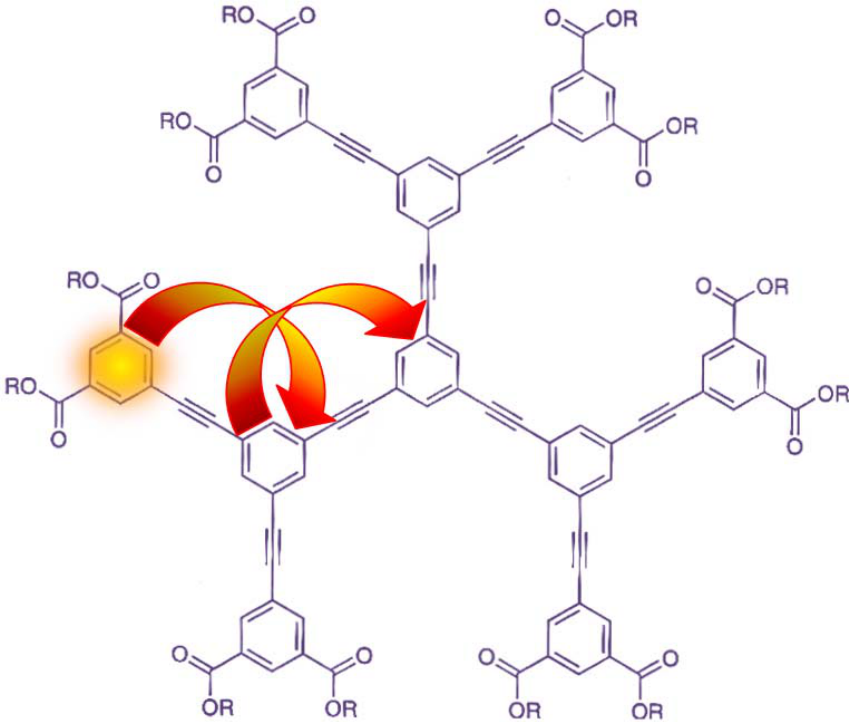
Figure 3. Two-step energy harvesting illustrated schematically in a second-generation phenylacetylene dendrimer, depicting initial electronic excitation of a peripheral phenyl group, which then acts as a donor for energy transfer to a neighboring first-generation acceptor; this then acts as a donor for energy transfer to the core phenaline